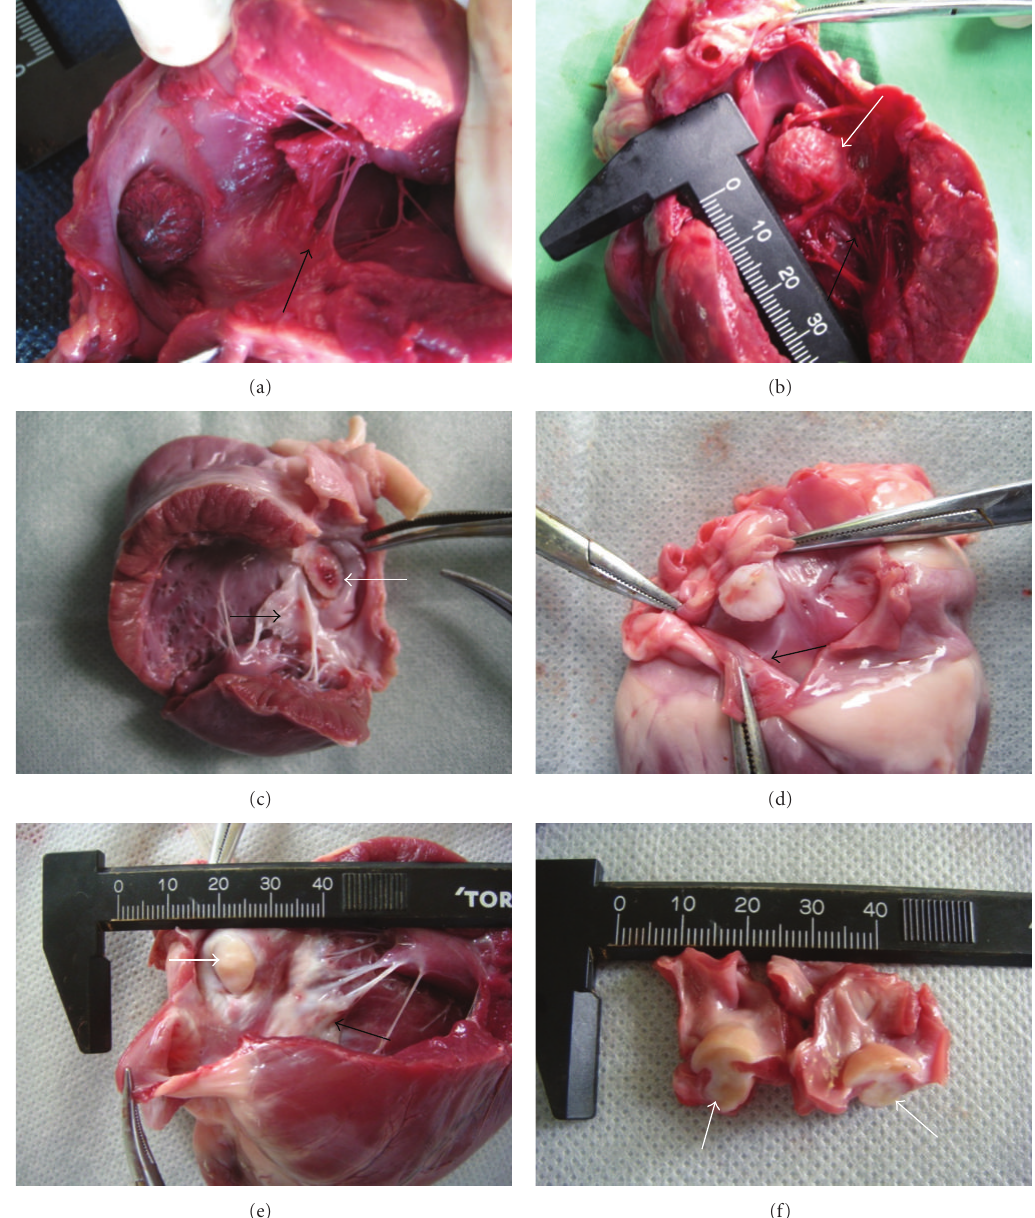
Figure 4: Gross inspection of the occluder at di ff erent time points after procedure (white arrows show the biodegradable occluder, and black arrows for the tricuspid annulus). (a) 2 weeks after procedure, the occluder shape was kept, the surface of occluder was covered with a layer of newborn film, PDO wire was clearly visible; (b) 4 weeks after procedure, the surface of occluder was covered with a certain amount of connective tissue, the occluder shape was kept, and partially fusion with the endocardial, PDO wire was still clearly visible; (c) 8 weeks after procedure, the surface of occluder was covered with reddish-white film, the PDO wire was still visible; (d) 12 weeks after procedure, the surface of the occluder was basically covered with milky-white film, mixed with a little red, the PDO wire was faintly visible; (e) 24 weeks after procedure, the surface of the occluder was covered with a dense porcelain-white film, the PDO wire has been unidentifiable; (f) 24 weeks after procedure, the occluder was bisected by a symmetrical cut, the occluder has become an integral part of the septum, the contour was still visible, but the PDO wire and PLA film have been unable to